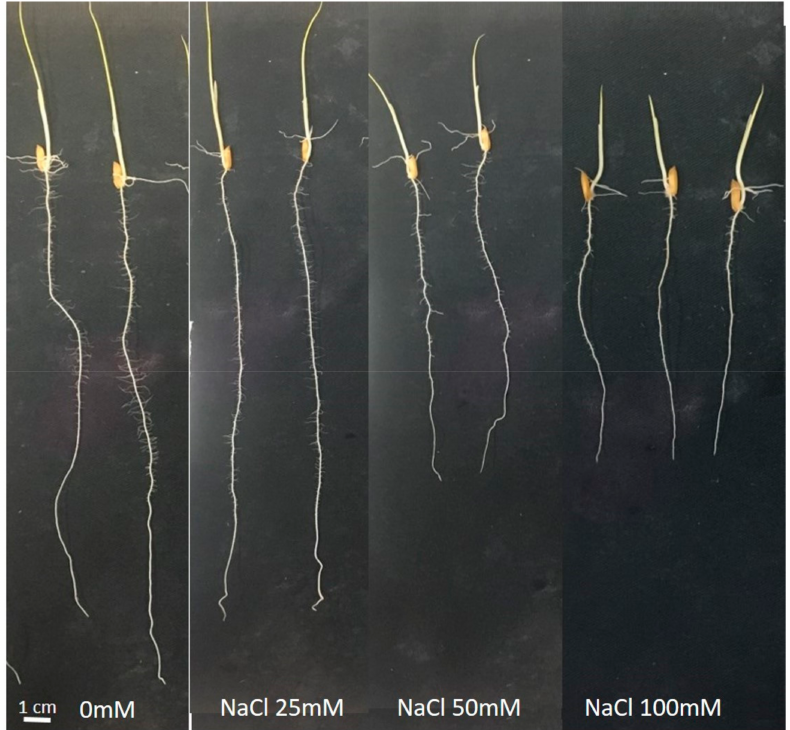
Figure A2. Seedlings of Oryza sativa cv. INCA LP-5 grown for 7 days in germination paper rolls at 28 to 30 ◦ C with one of four salt concentrations (0, 25, 50 and 100 mM